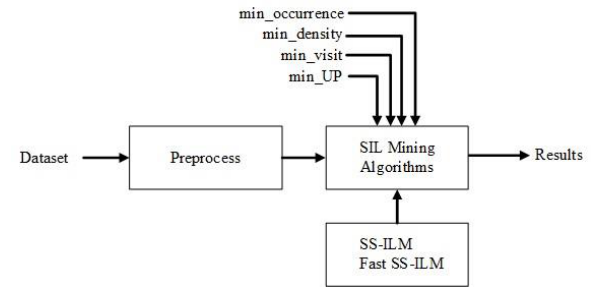
Figure 3. Experimental